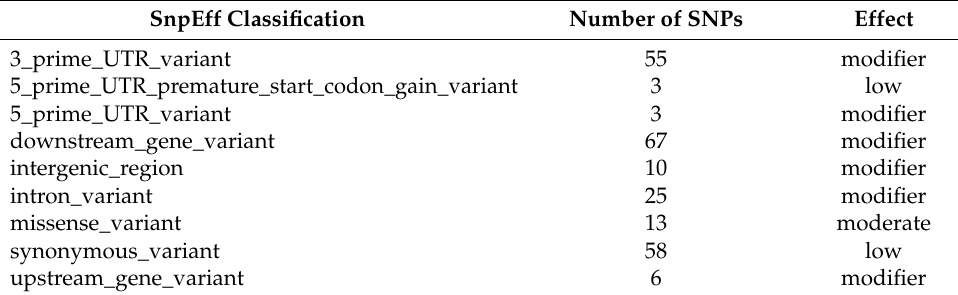
Table 5. Classification of nucleotide substitutions (SNPs) effects.